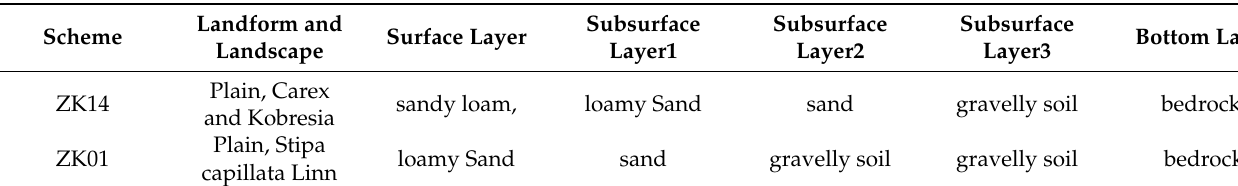
Table 2. Landscape and soil profiles of the two soil parameter schemes of the Gaize area.